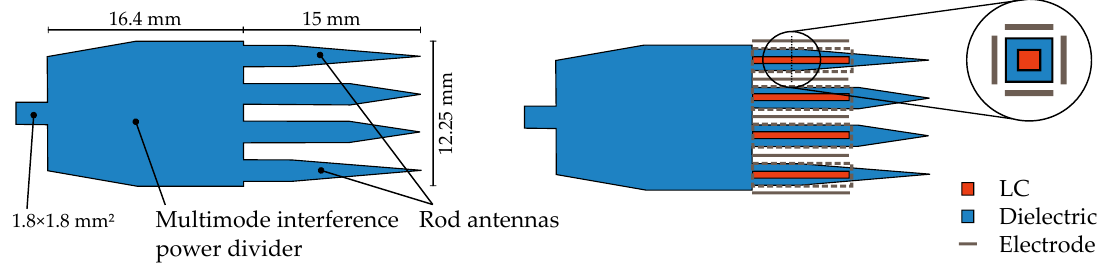
Figure 29. Fully dielectric antenna array presented in [44]. ( Left ) It consists of four rod antennas which are fed by a multimode interference power divider; ( Right ) Further development could be the integration of the subwavelength fiber phase shifter.